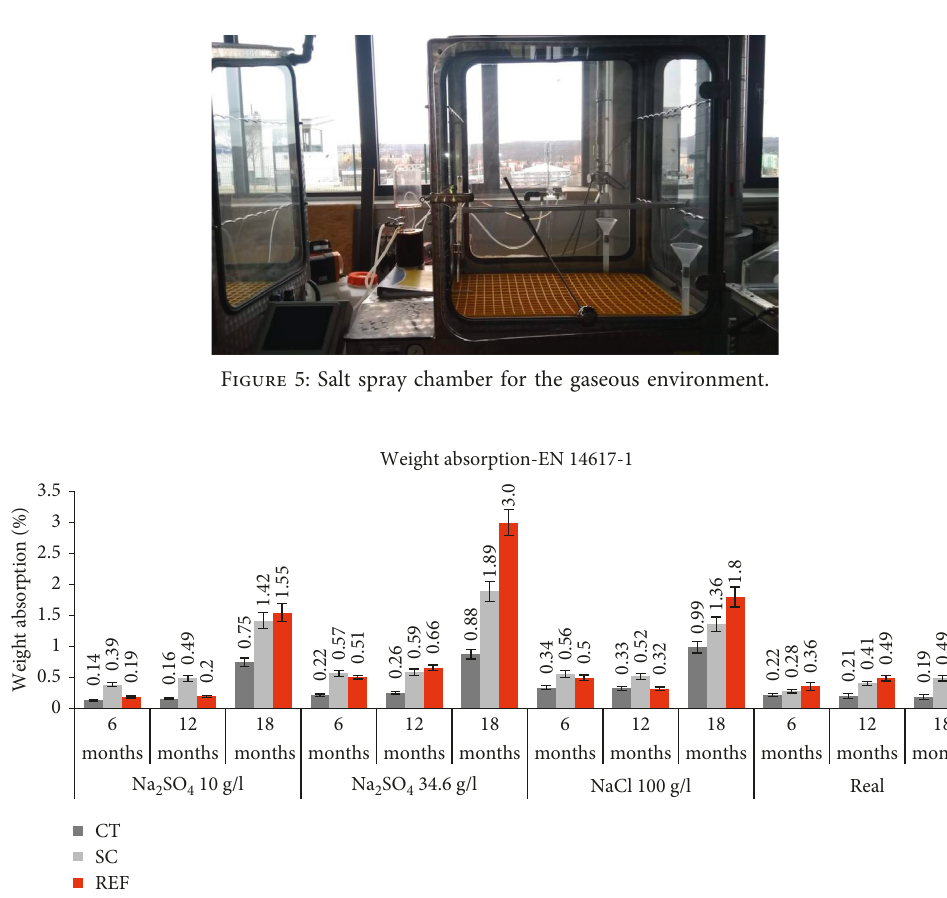
Figure 6: Comparison of the absorption of concrete exposed to liquid aggressive media and the real environment. The error bars represent the range of measurements for 3 samples.